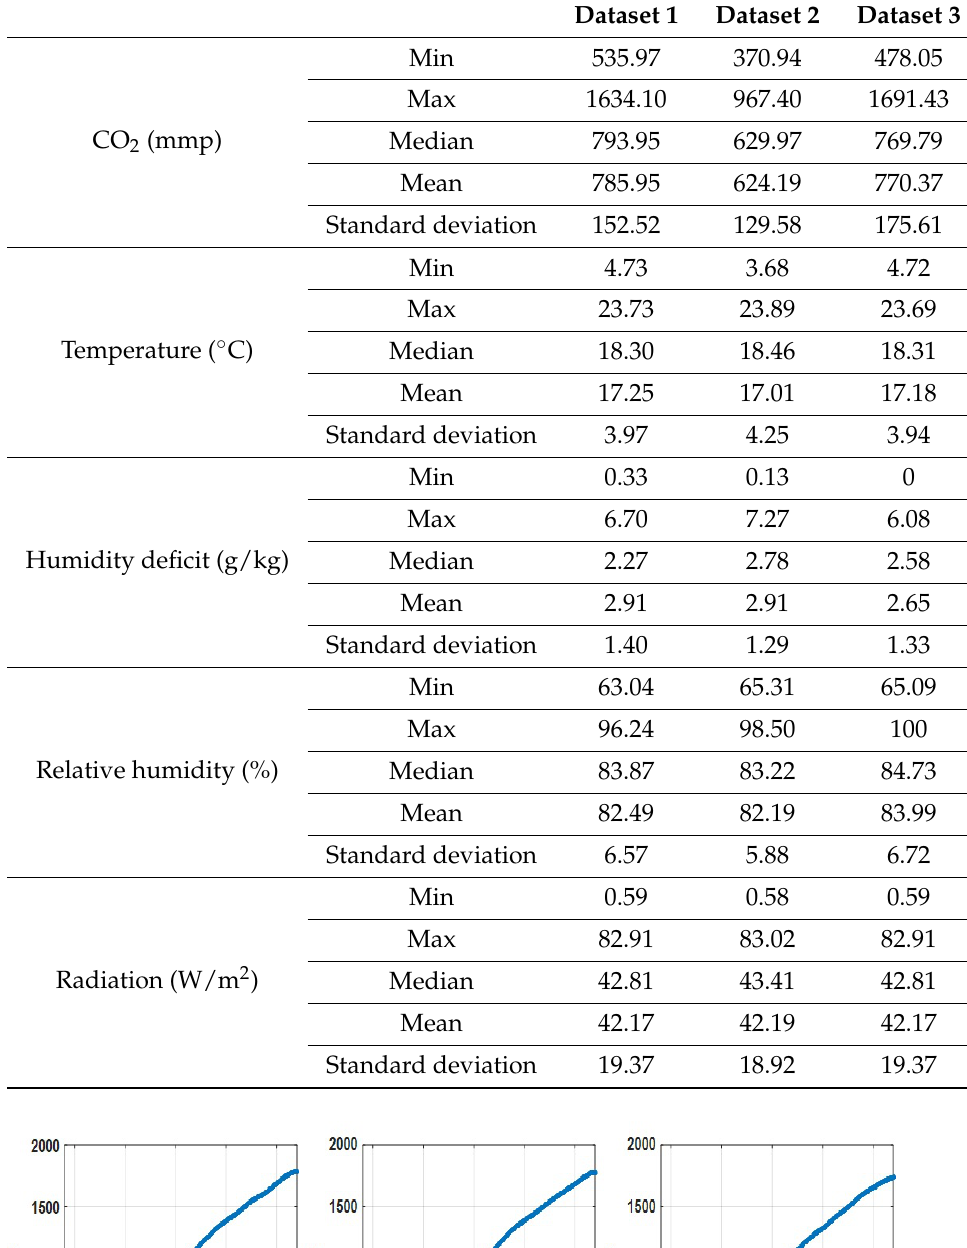
Table 2. Descriptive statistics of greenhouse environmental parameters associated with differ- ent datasets.